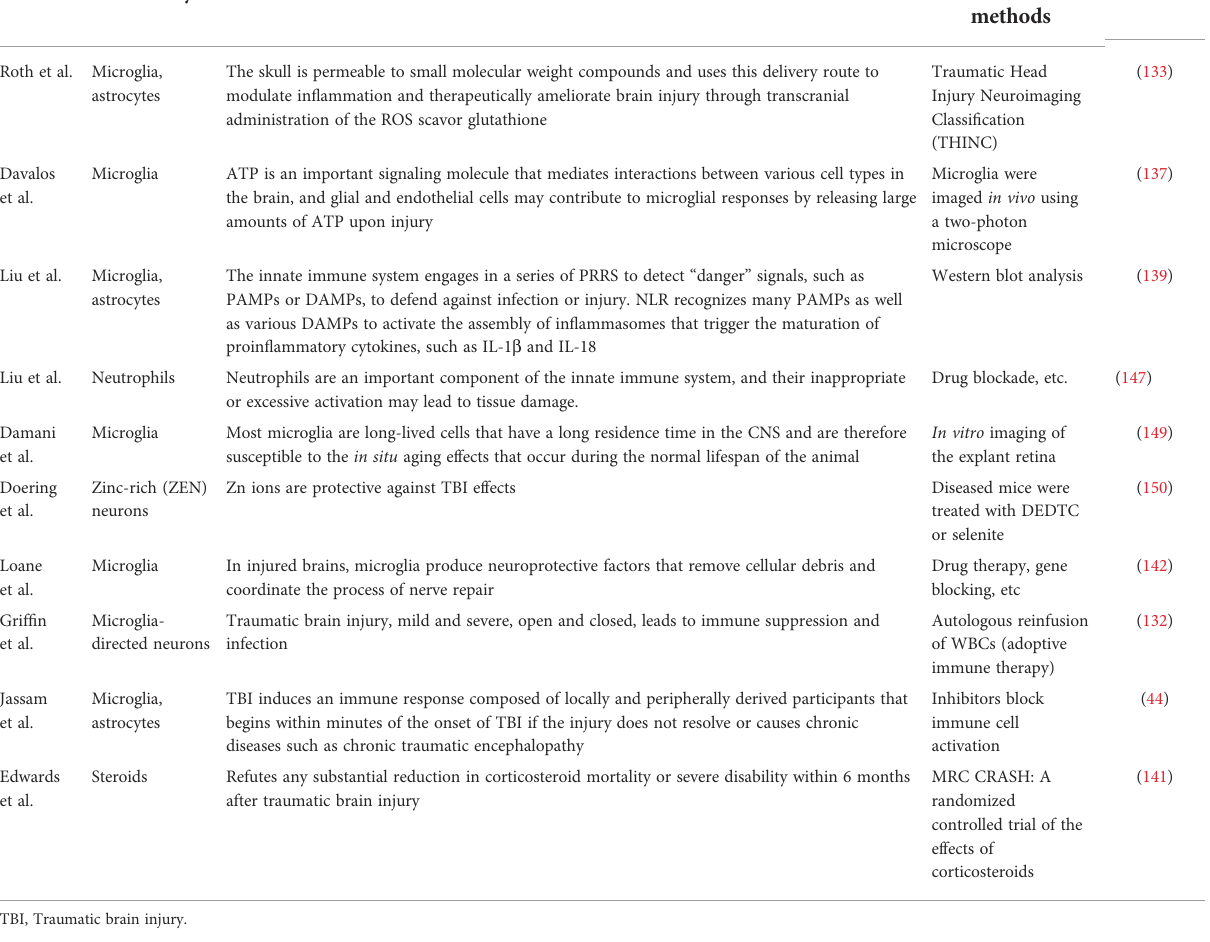
TABLE 2 Studies on the role of different immune cells in